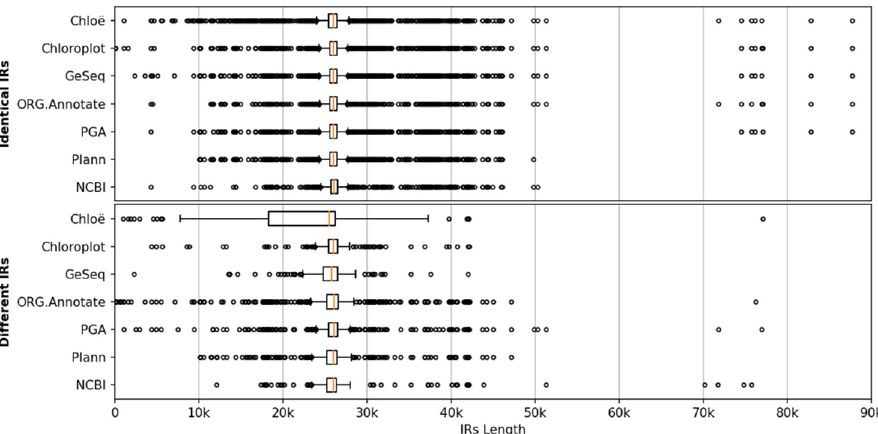
Figure 3. Box plots of the IR length distributions in complete chloroplast genome sequences grouped by type of IRs identified (identical or different) using six annotation tools (and those annotated in NCBI).